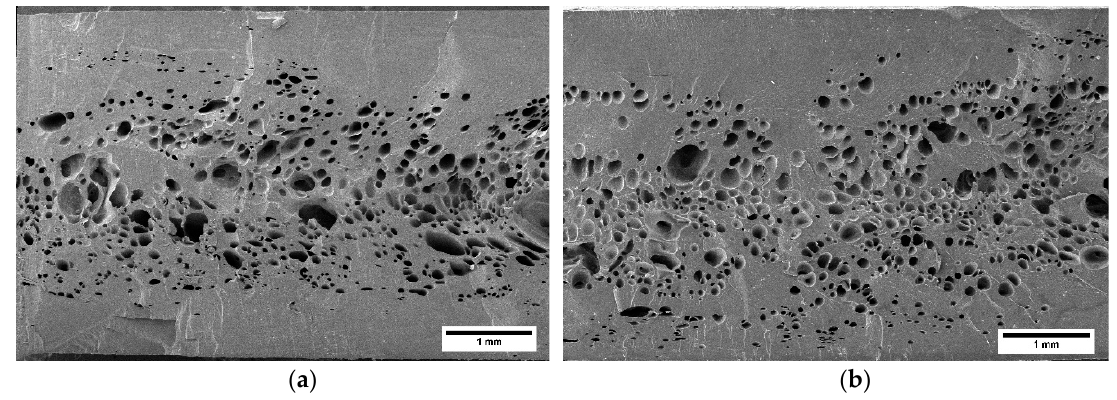
Figure 7. TD plane of ( a ) 215 L and ( b ) 215 H foams. The scale bar represents 1 mm.